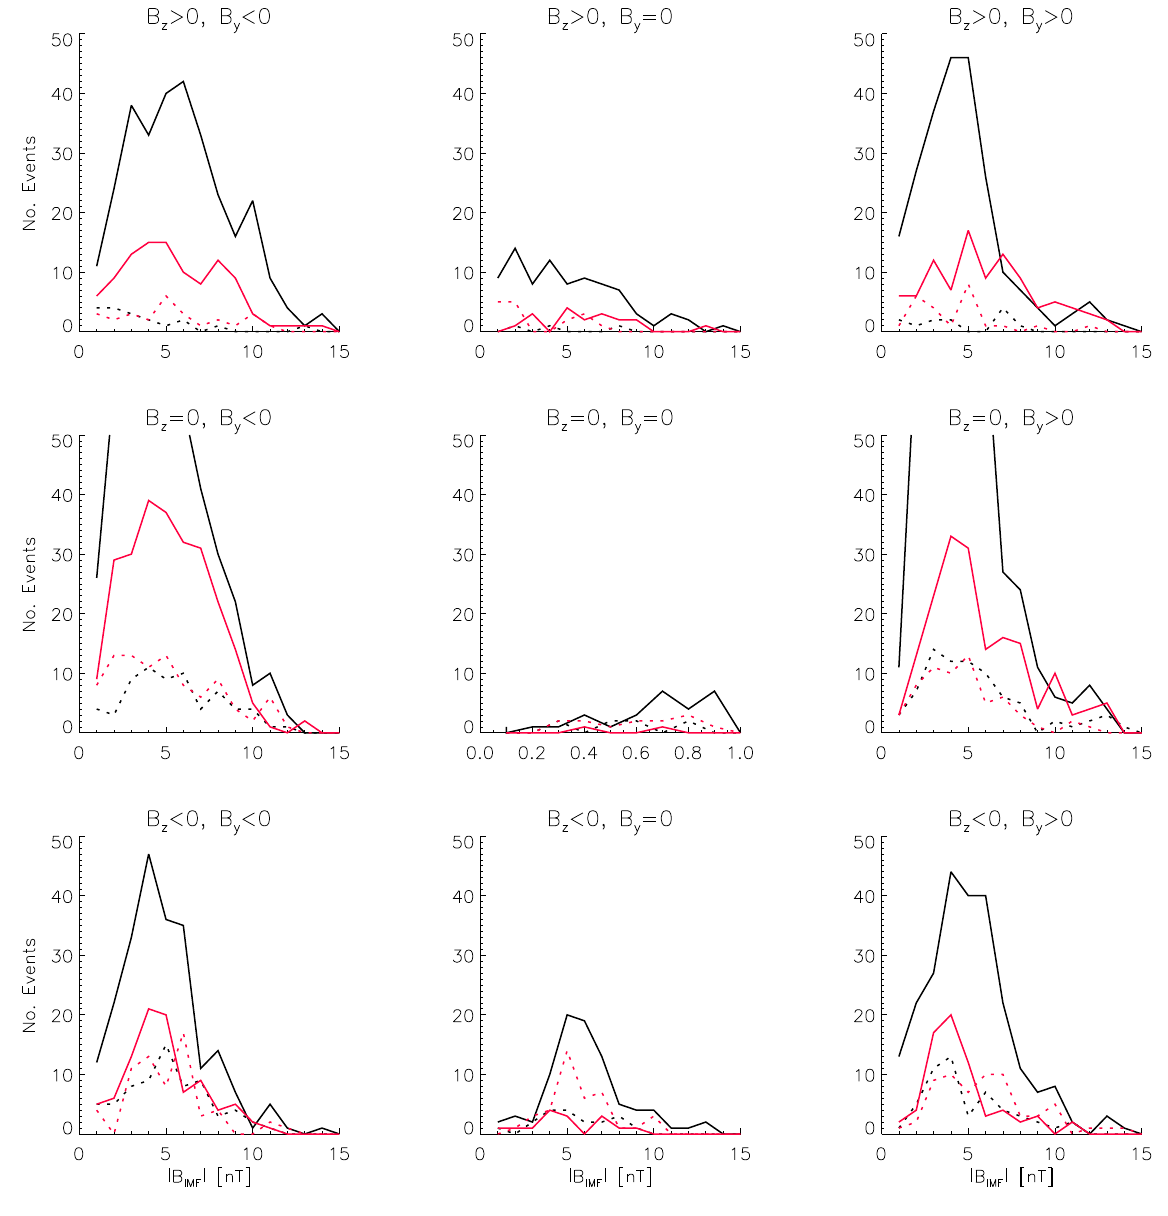
Fig. 3. IMF magnitude distribution of our events. NH curves are black while the SH are shown in red. Solid lines are for summer, dotted lines are for the winter hemisphere. Note the 0 to 1 IMF magnitude range for the center panel.